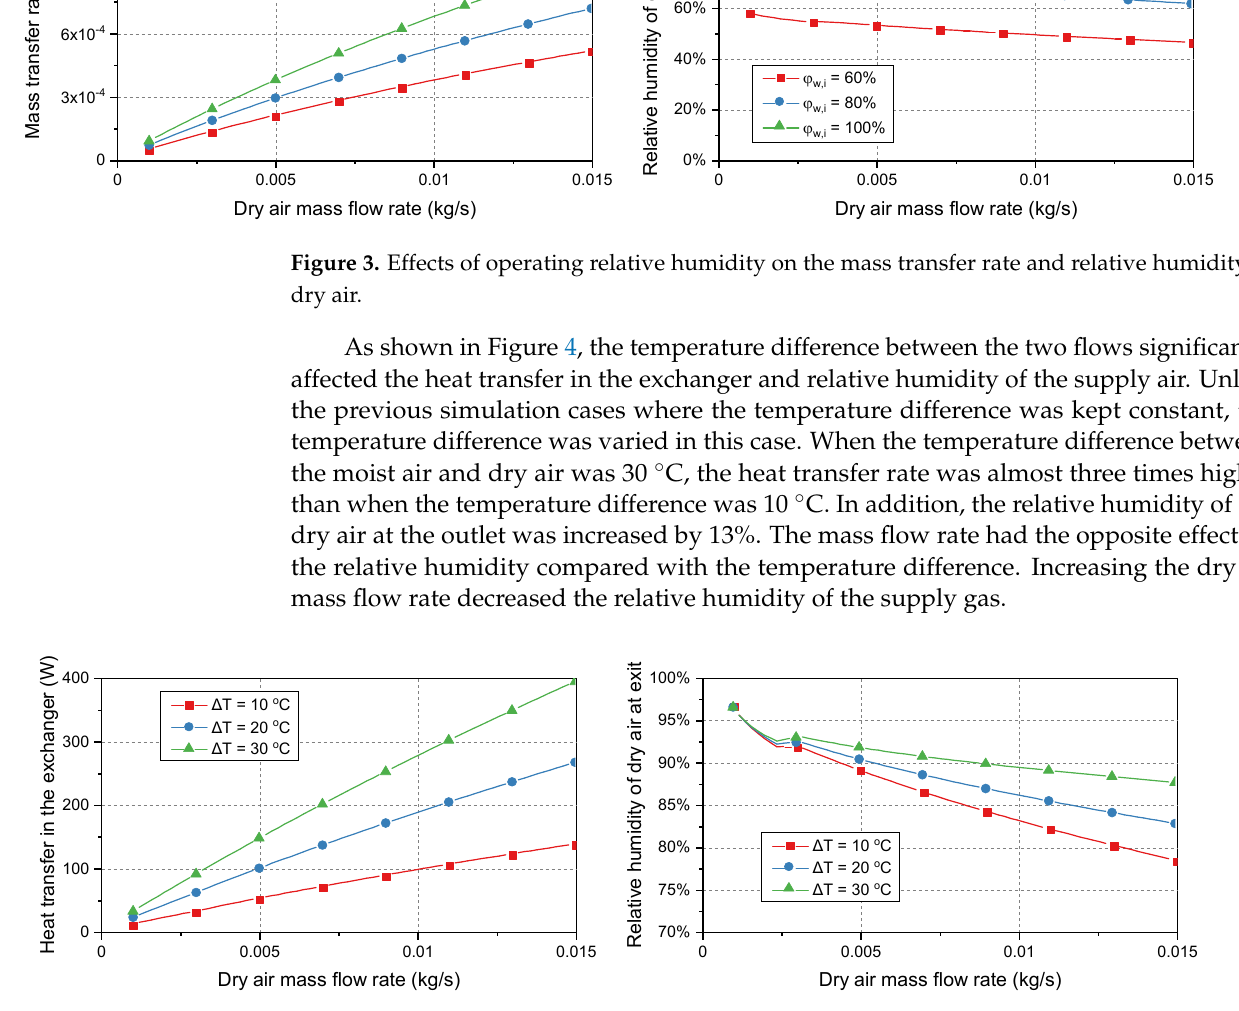
Figure 4. Effects of temperature difference on the heat transfer rate and relative humidity of dry air.